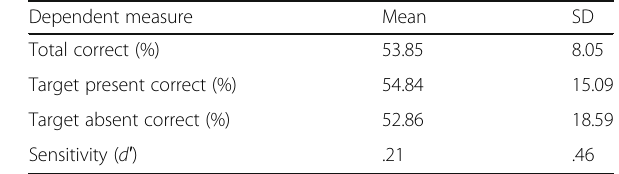
Table 4 Experiment 2: Mean percentage accuracy for the ventricular function categorization task when detection was correct for the echocardiographers ( n = 30) Category